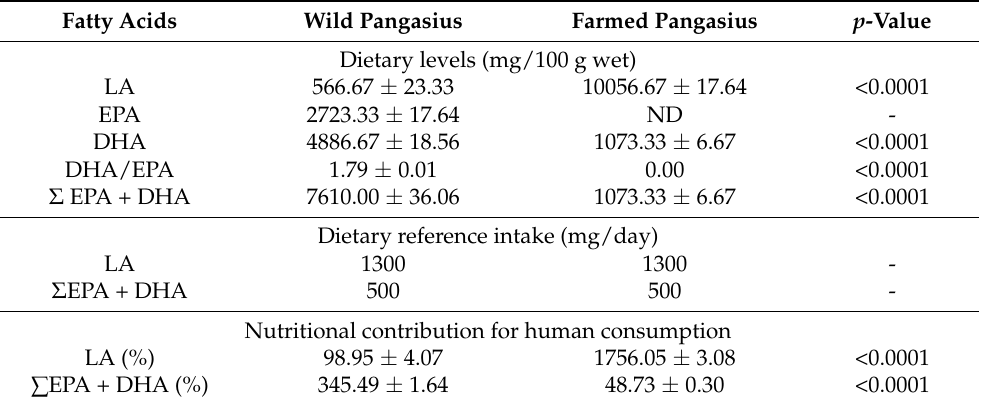
Table 6. Fatty acid composition (wet basis) as total fatty acids in mg/100 g and nutritional contribution of wild pangasius versus farmed pangasius for human